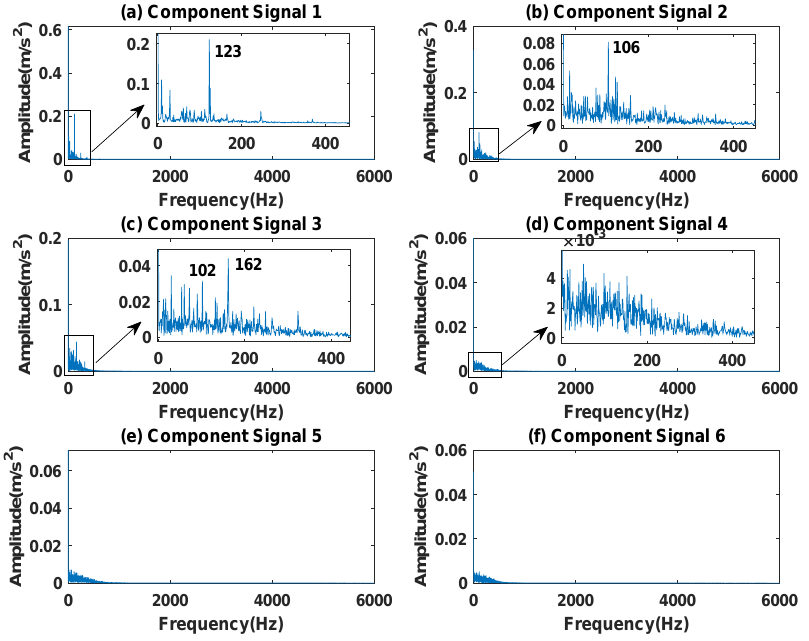
Figure 28. Decomposition results of ISVDP with m = 16 and J = 3: ( a – f ) envelop of 1st to 6th subcomponents, respectively.